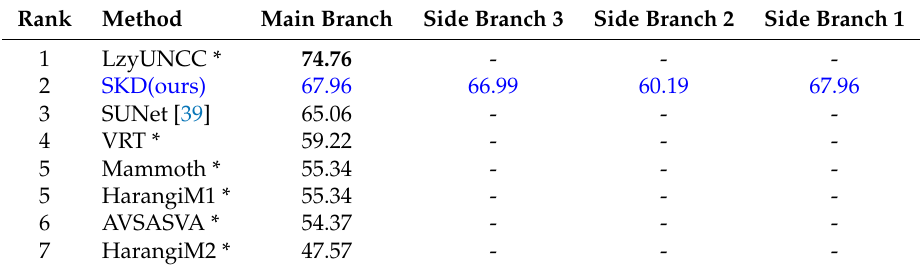
Table 2. Comparison with state-of-the-art results on IDRiD dataset. Our results are bolded in blue. * indicates that the result is obtained from [33]. Consistent with the official evaluation criteria, only the accuracy indicator (unit: %) is given